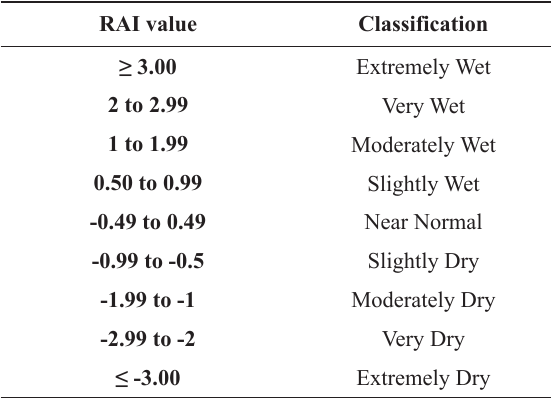
Table 1: Classification of RAI intensity. RAI value Classification